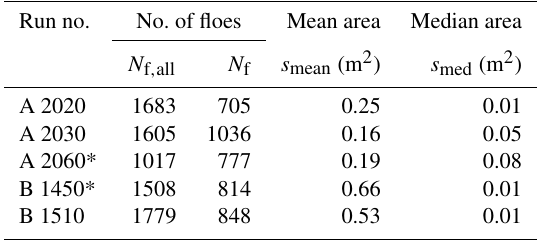
Table 2. Summary of FSD data obtained from the analyzed images. Run